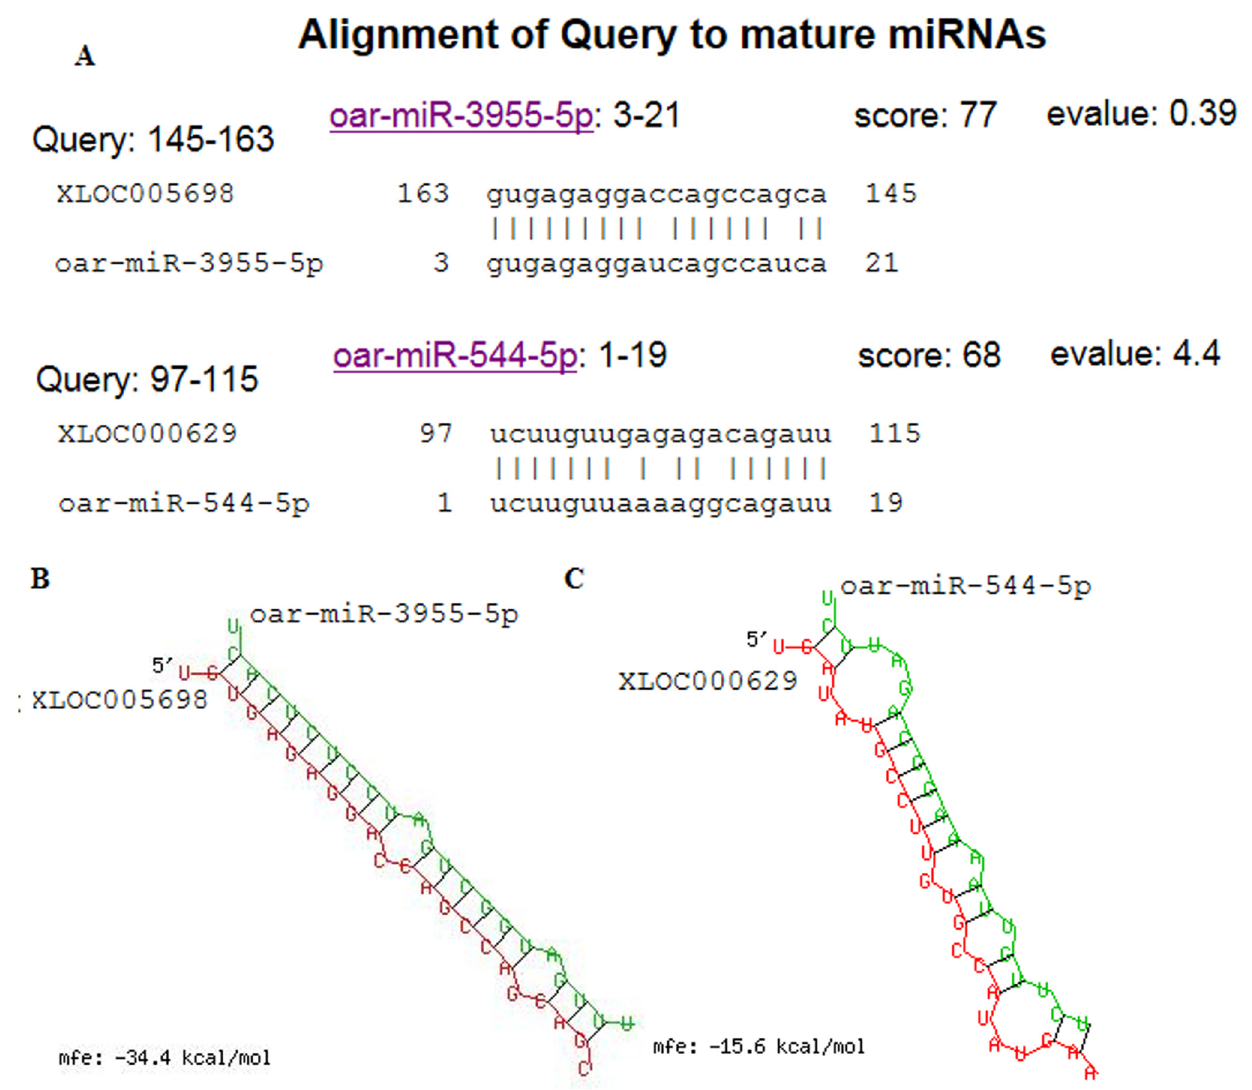
Fig 6. Bioinformatics predicted oar-miR-3955-5p binding sites on XLOC005698, and oar-miR-544-5p binding sites on XLOC000629. (a) Alignment between XLOC005698 and oar-miR-3955-5p as well as between XLOC000629 and oar-miR-544-5p. (b) The oar-miR-3955-5p miRNA binding sites on XLOC005698. (c)The oar-miR-544-5p miRNA binding sites on